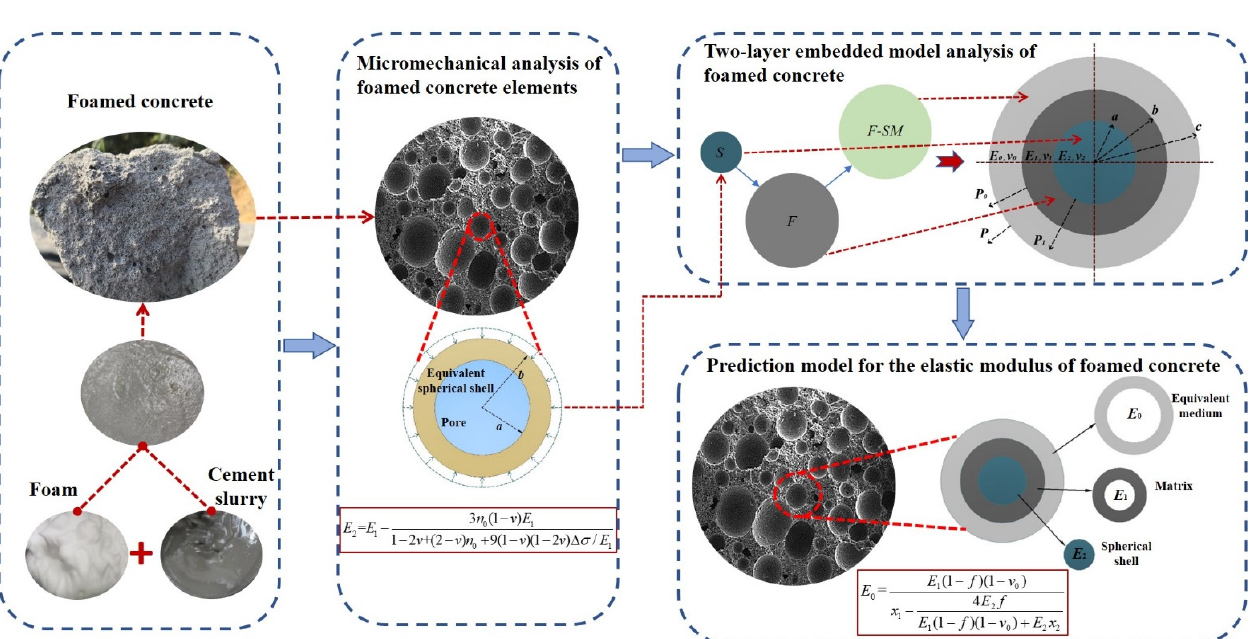
Figure 7. Flowchart of the calculation for the elastic modulus of foamed concrete.